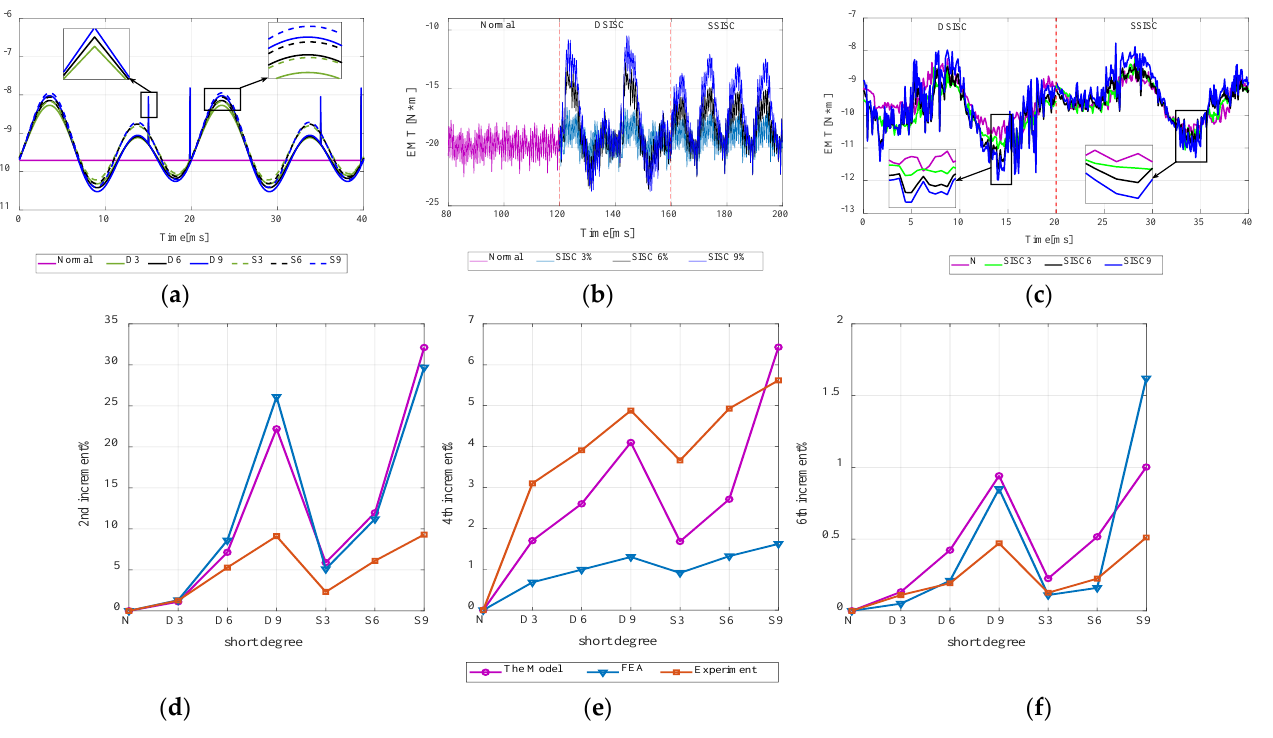
Figure 8. EMT in varied DSISC degree cases: ( a – c ) waves by model, FEA and experiment, and ( d – f ) harmonic variations. Compared with SSISC, DSISC, with the same short circuit degree, has less influence on MFD and phase current of the generator, but has a greater impact on EMT. The results correspond to the above theoretical